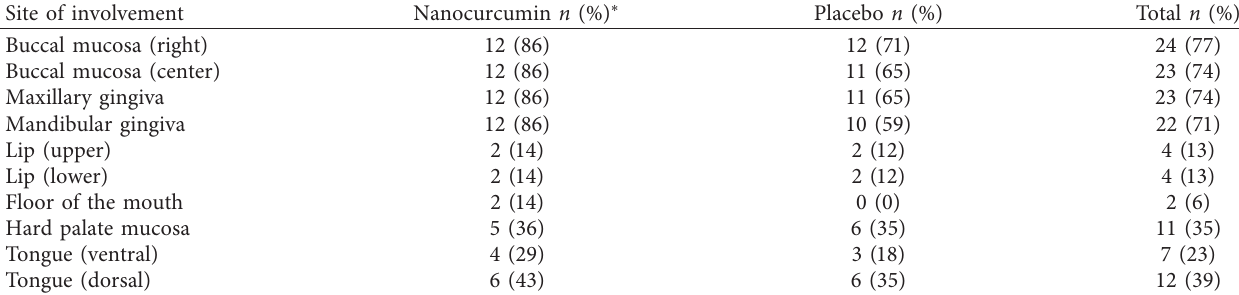
Table 1: The distribution of patients according to the location of lesion in two groups.